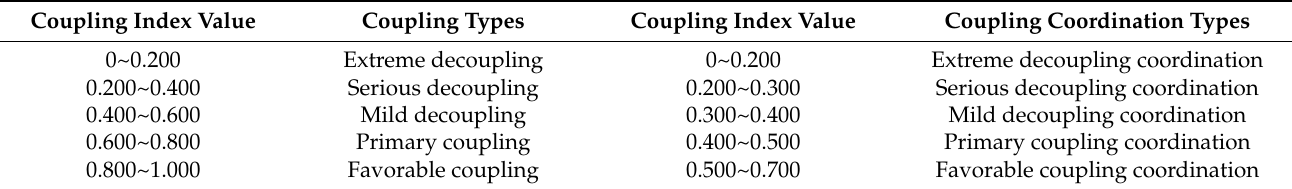
Table 2. Classification of the coupling coordination evaluation